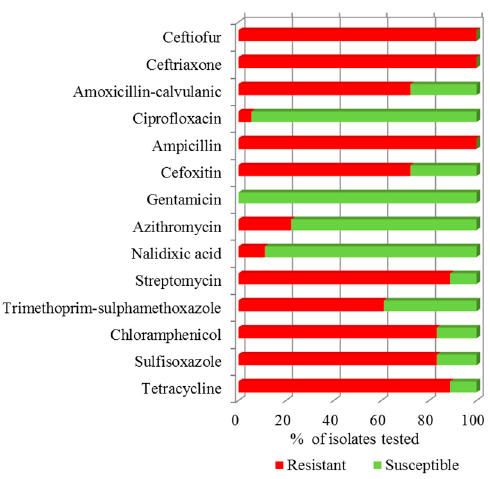
Figure 2. Antimicrobial Susceptibility test (AST). The AST results of the 18 E. coli selected isolates against 14 different antibiotics are presented as the percentage of isolates that were resistant (red), or susceptible (green) to the antibiotics listed on the y -axis.